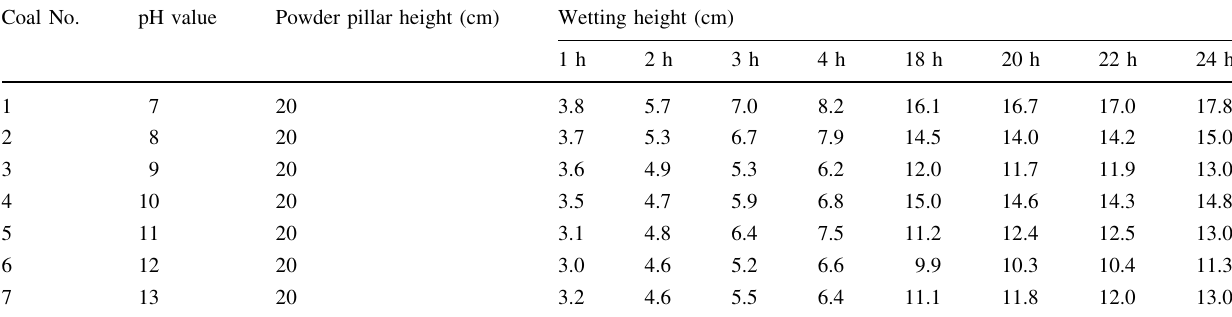
Table 2 Experimental results of pulverized coal’s self-priming in solutions with different pH values (second group) Coal No.